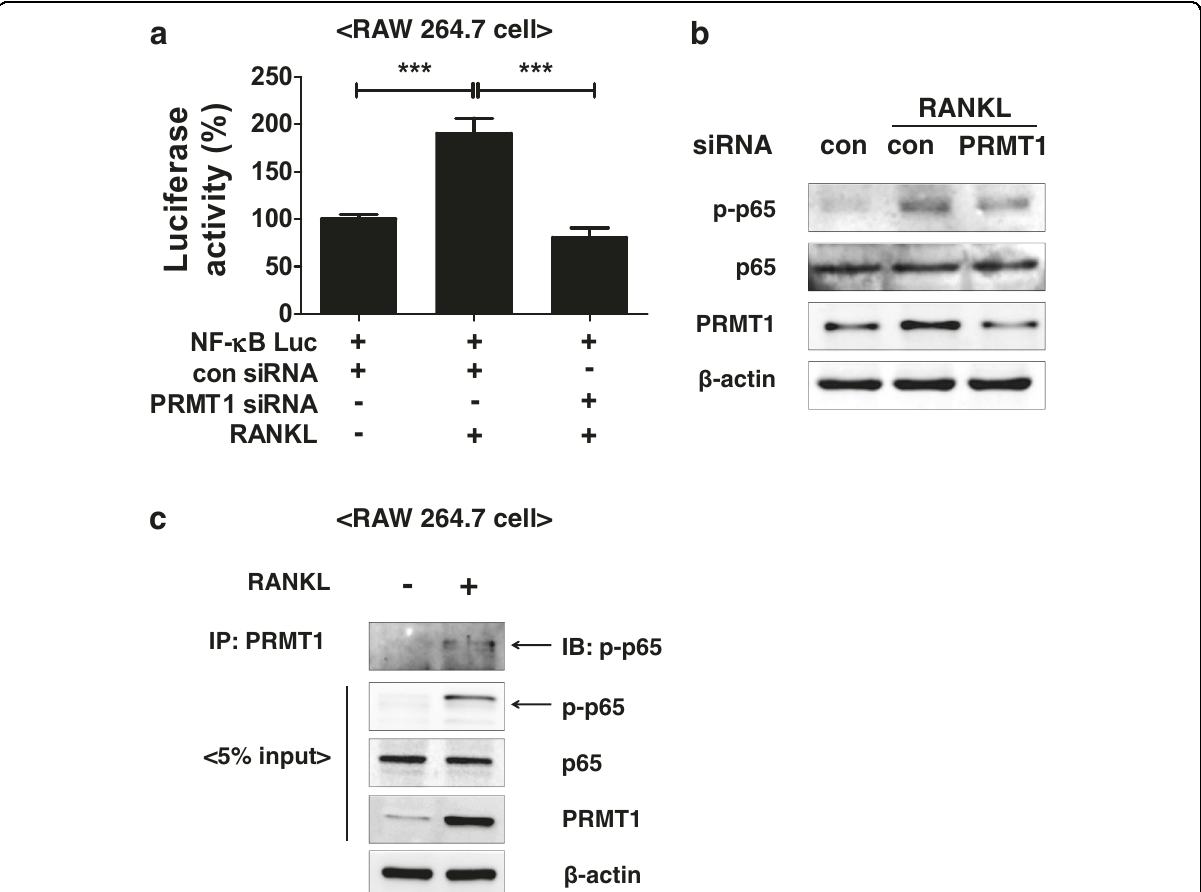
Fig. 5 PRMT1 interacts with NF- κ B subunit p65 during RANKL-mediated osteoclastogenesis. a RAW 264.7 cells were transfected with control or PRMT1 siRNA according to the forward transfection method. After 24 h, the cells were transfected with pGL4.32- luc2P /NF- κ B-RE and β - galactosidase plasmids. After 24 h of transfection, the cells were treated with RANKL (100 ng/ml) in the presence of M-CSF (30 ng/ml) for 24 h and then lysed with passive lysis buffer for the luciferase assay. Luciferase activity was measured and normalized to β -galactosidase activity. The data are presented as the mean ± SD. *** p < 0.001. b BMDMs were transfected with control or PRMT1 siRNA and treated with RANKL for 24 h. Levels of phosphor- and regular p65, PRMT1, and actin were examined by western blot analysis. c RAW 264.7 cells were incubated with or without RANKL (100 ng/ml) in the presence of M-CSF (30 ng/ml) for 24 h and immunoprecipitated with